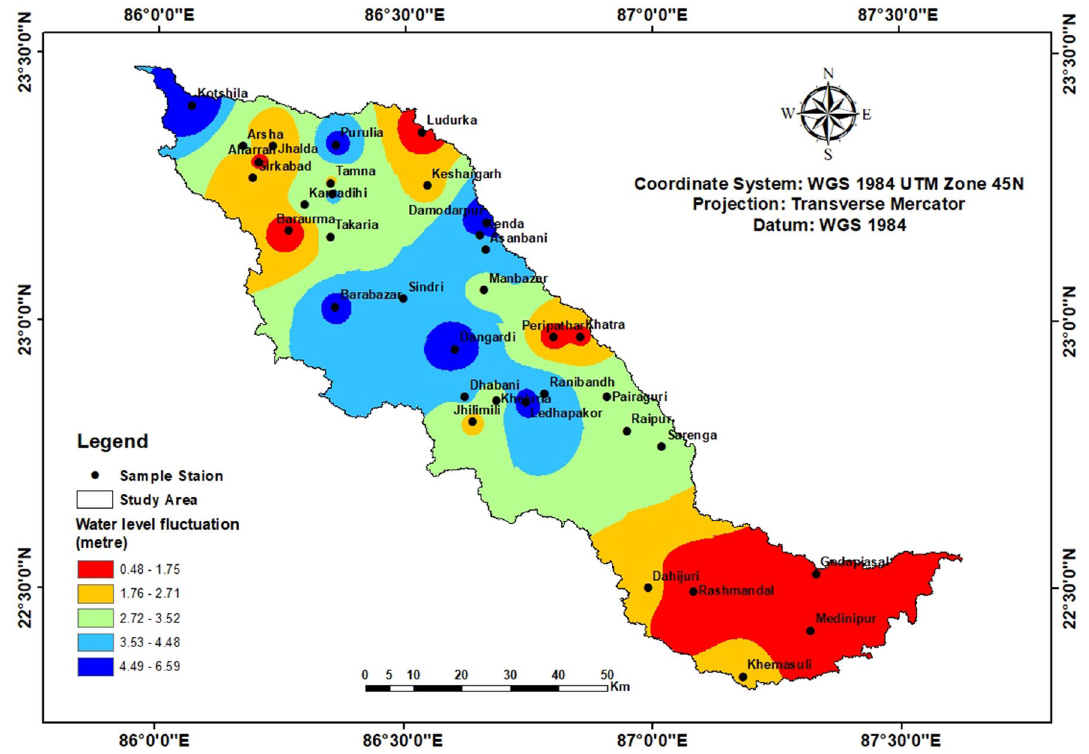
Fig. 16 Map showing the spatial variation of groundwater fluctuation in Kangsabati River